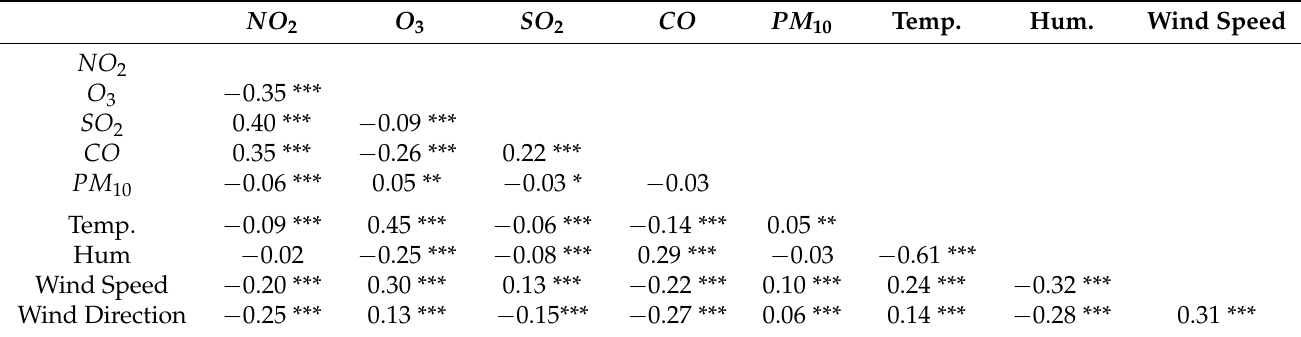
Table 3. Correlation analysis between weather climatology and air-pollution components SO 2 , NO 2 , O 3 , CO , and PM 10 . NO 2 O 3 SO 2 CO PM 10 Temp. Hum.